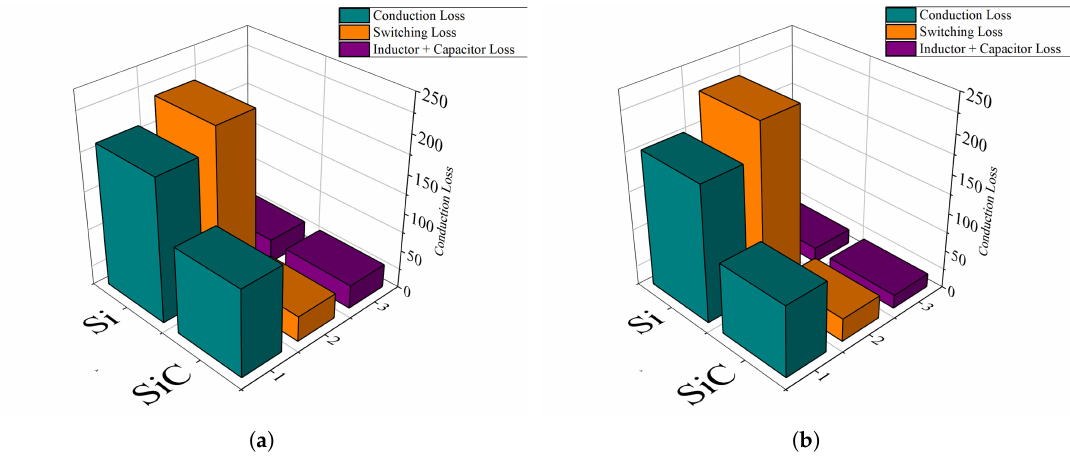
Figure 23. Loss comparisons at ( a ) 100% and ( b ) 75%.